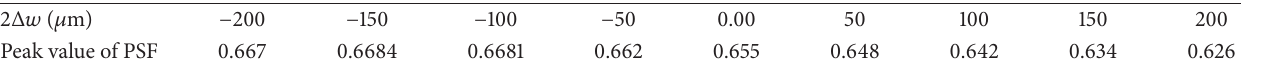
Table 6: Peak value of PSF as a function of 2Δ𝑤 .